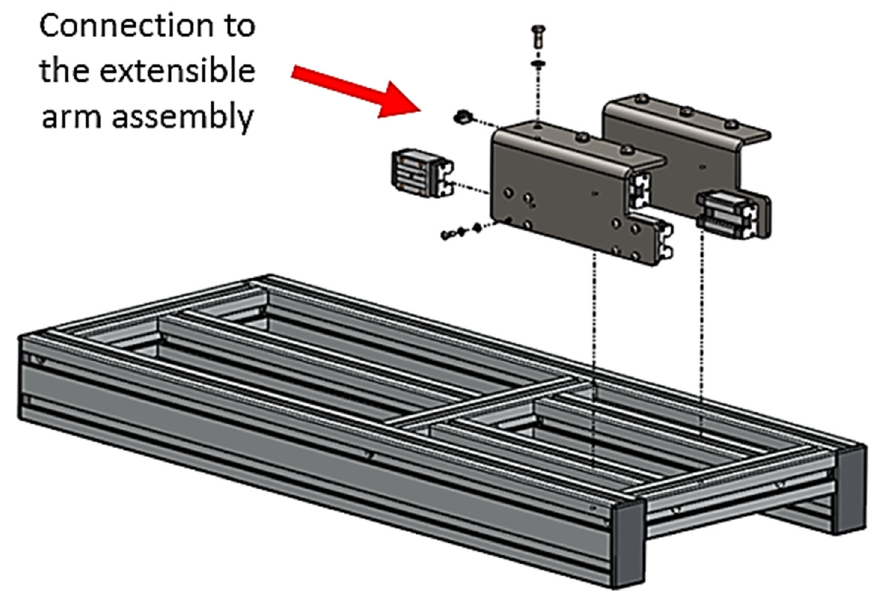
Figure 24. Aluminum profile frame with connection and support function.